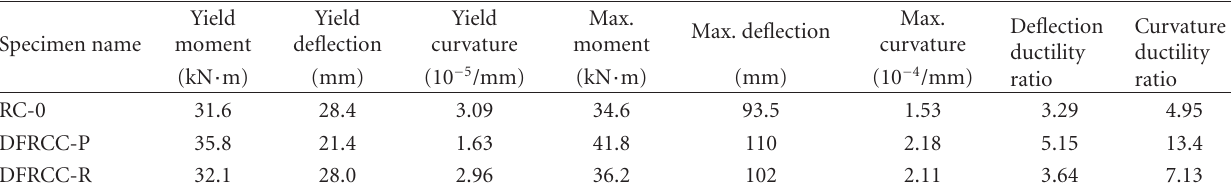
Table 6: Experimental results of slab